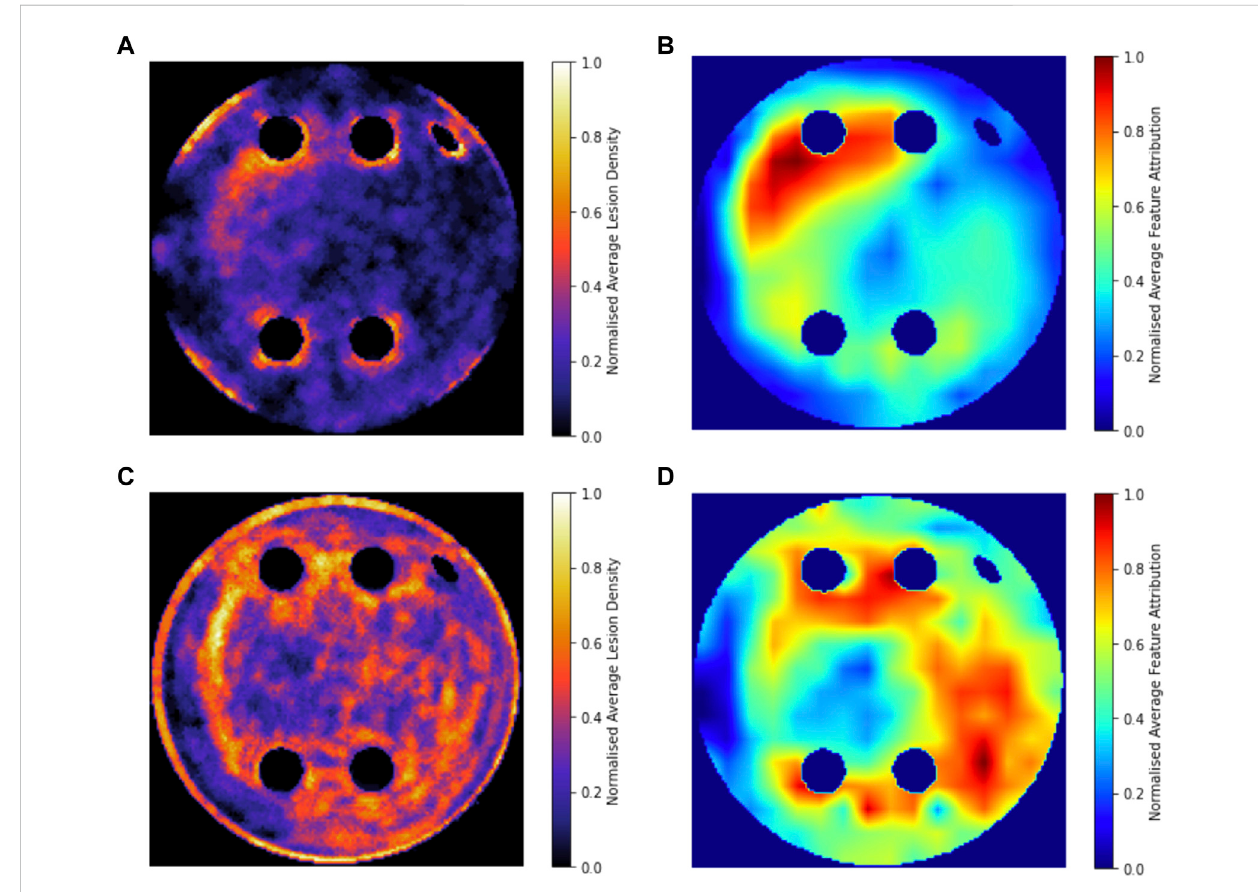
FIGURE 9 Averaged and normalised ablation lesions and GradCAM FA maps for FIBRO and ROTOR on the hold-out test set. (A) . Ablation lesions for ROTOR. (B) . FA map for ROTOR. (C) . Ablation lesions for FIBRO. (D) . FA map for